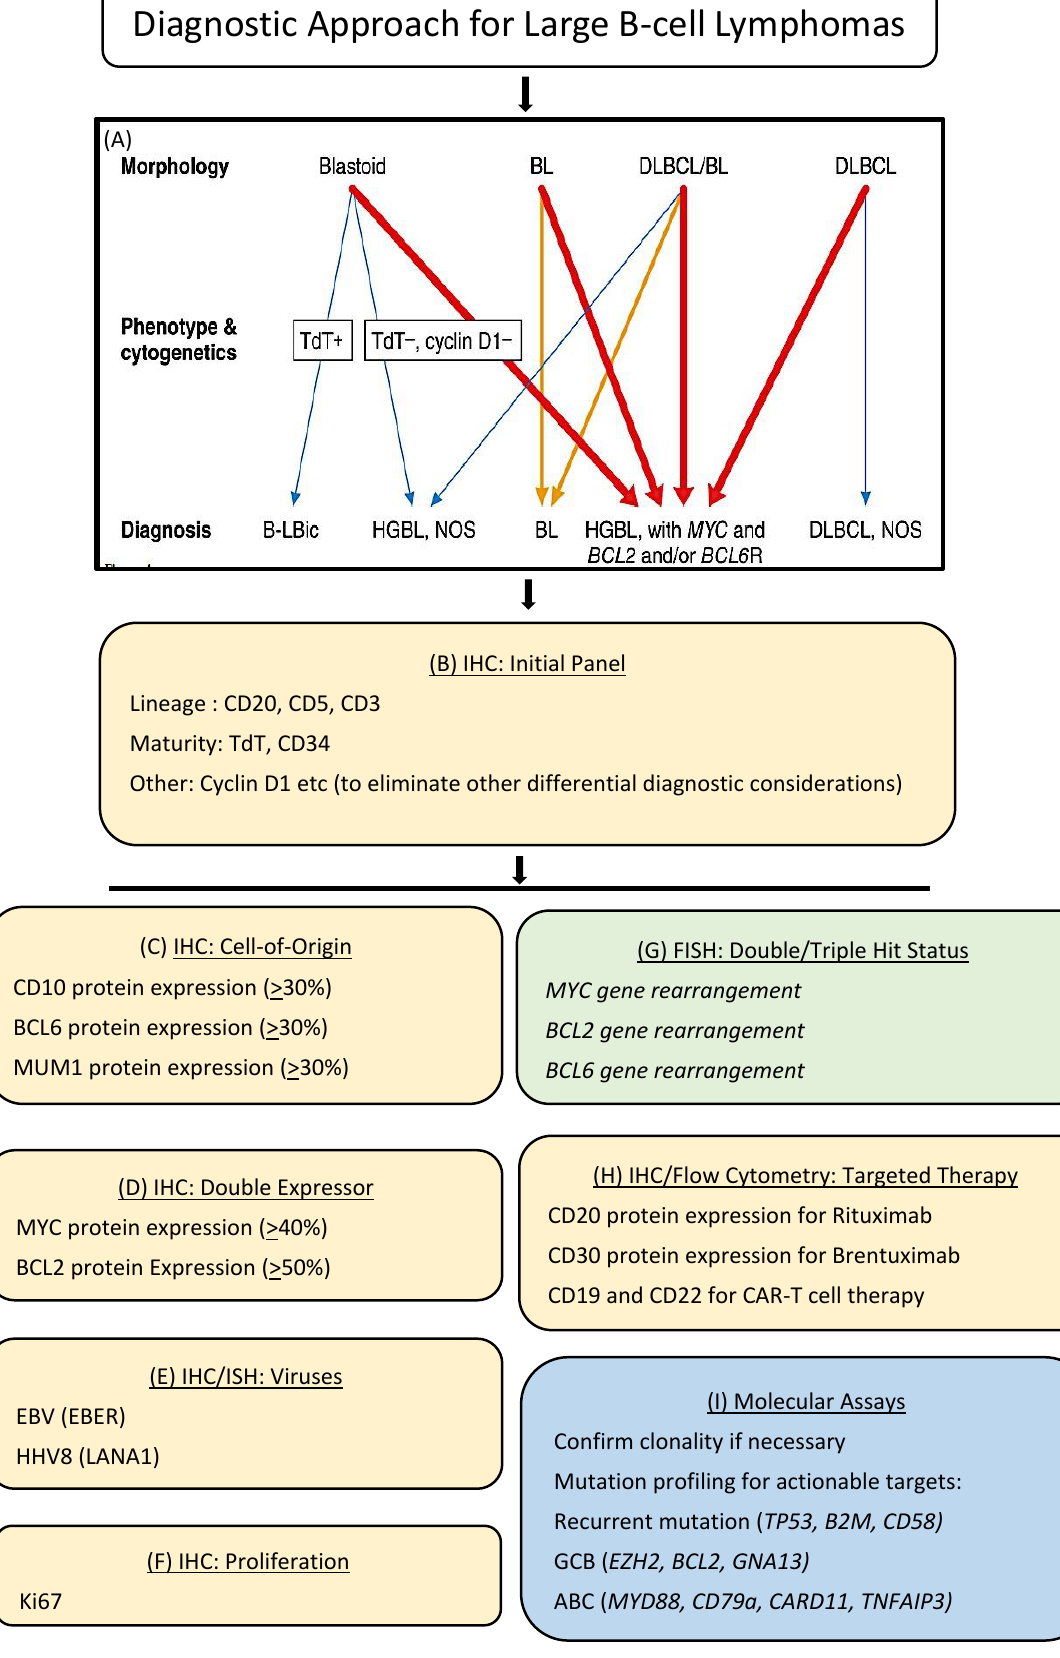
Figure 2. Precision diagnostic algorithm for diffuse large B-cell lymphoma. The diagnosis and subclassification of